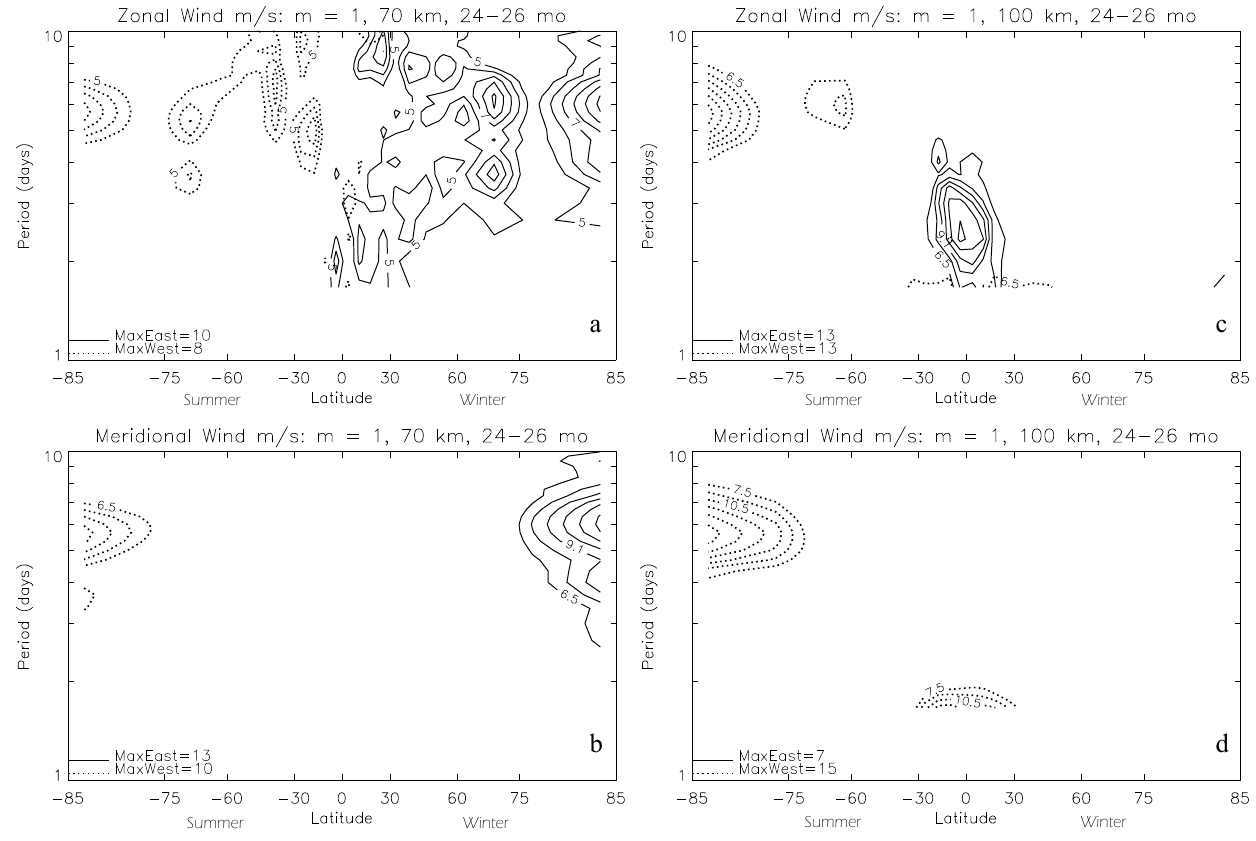
Figure 12 Fig. 12. Spectra for m=1 PWs at altitudes of 70km ( a , b ) and 100km ( c , d ) . Note that for m=1, the waves do not vanish at the poles, unlike those for m > 1. The Mercator projection is applied to expand the regions at high latitudes where the waves are prominent. Both eastward and westward propagating Rossby type PWs are shown at 70km in the winter and summer hemispheres, respectively. At 100 km, the zonal winds near the equator (c) are again the signatures of Kelvin waves. (The westward propagating winds with periods close to 1 day near the equator are trace signatures of the diurnal